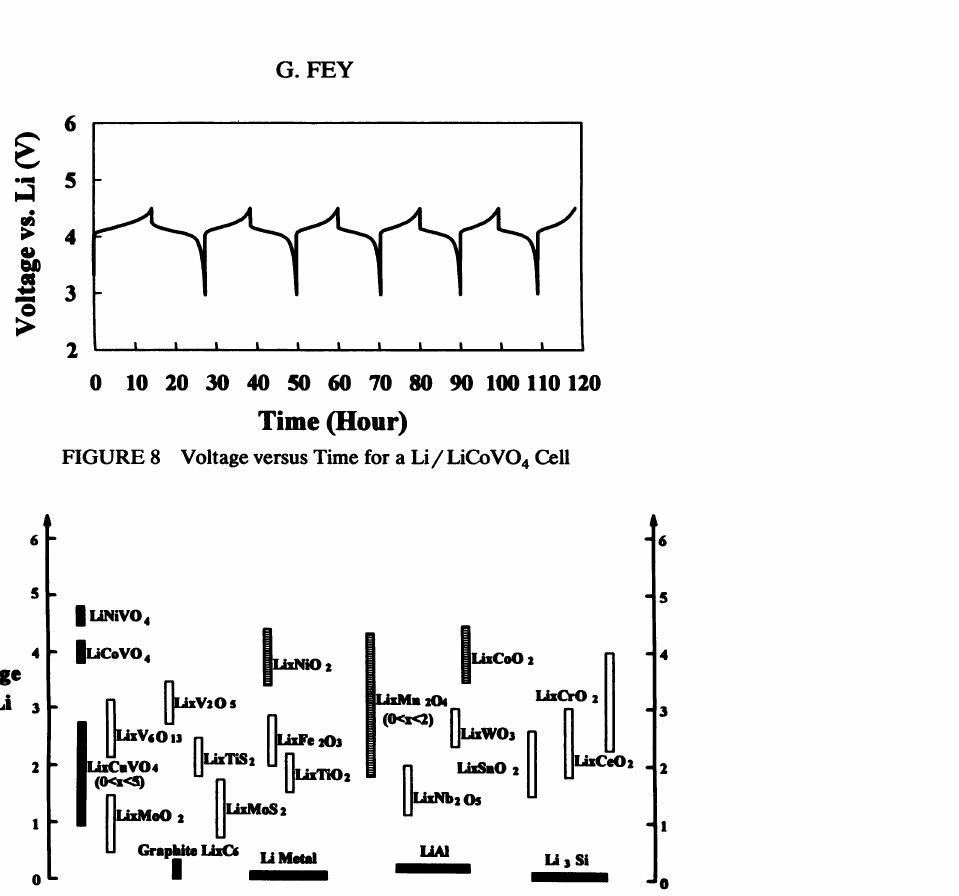
FIGURE 9 Approximate Working Voltage of Lithiated Transition Metal Oxides and